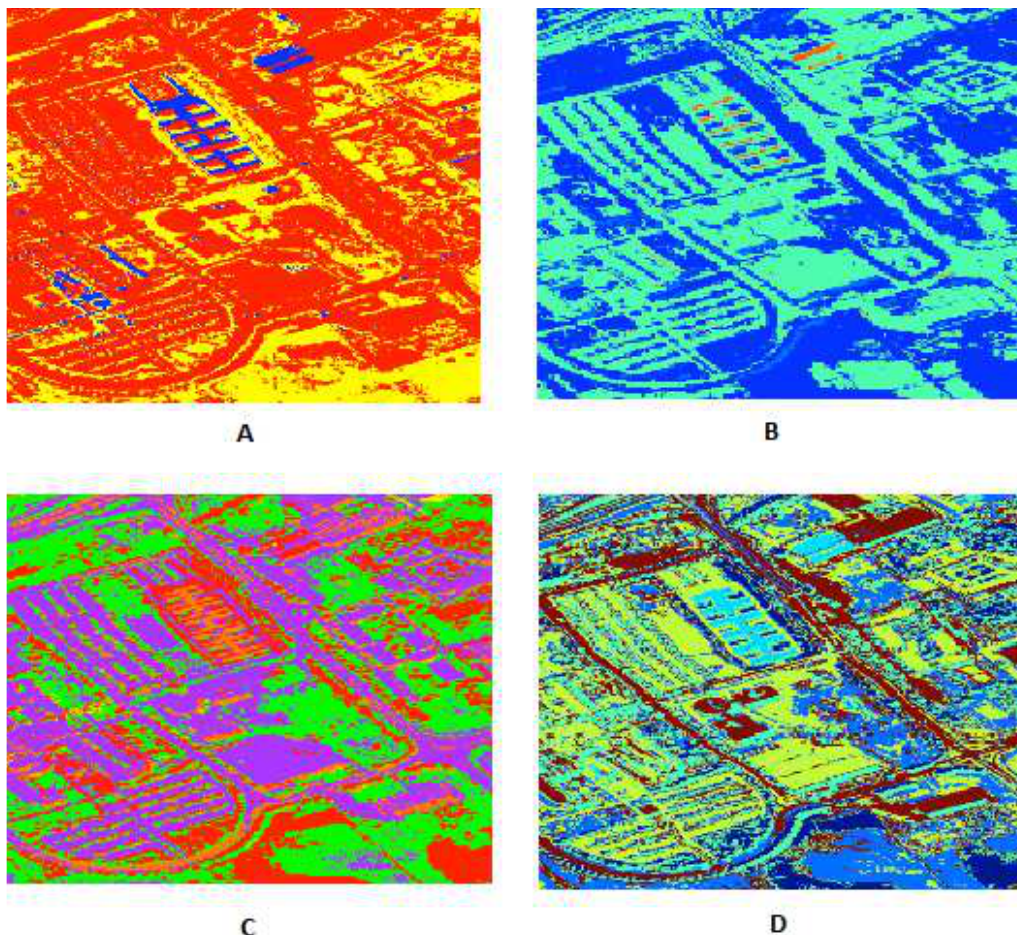
Figure 5. The classification of PaviaU image considering as training the 1% ( A ), the 10% ( B ), the 30% ( C ) and the 50% ( D ) of the